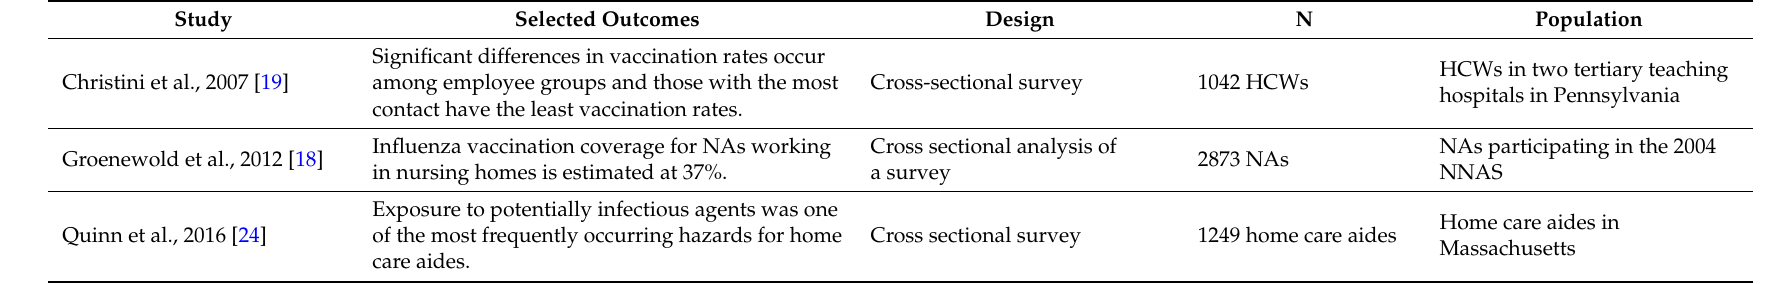
Table 1. Summary of literature reviewed for occupational health and safety hazards to nursing assistants—biological hazards.